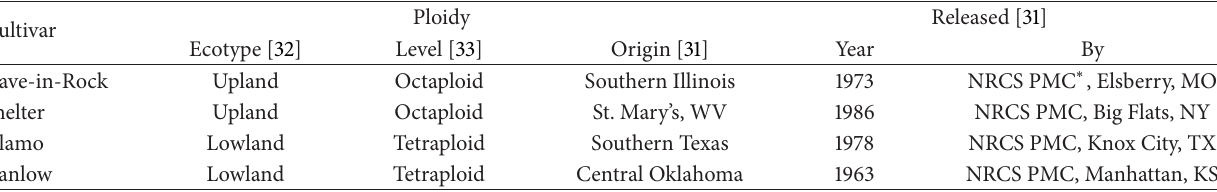
Kanlow NRCS PMC: Natural Resources Conservation Service, Plant Materials